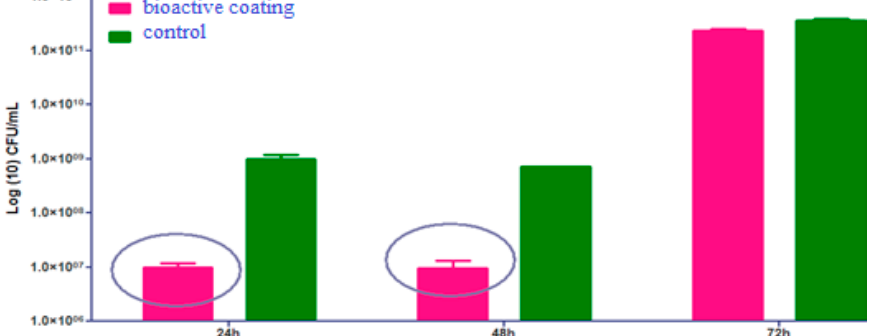
Figure 8. Graphic representation of the number of S. aureus biofilm embedded viable cells (log 10 CFU (colony forming units)/mL) harvested from the coated (bioactive coating) and uncoated control.